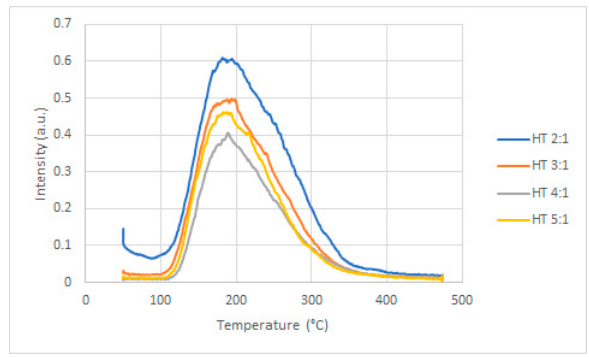
ff erent HT supports.